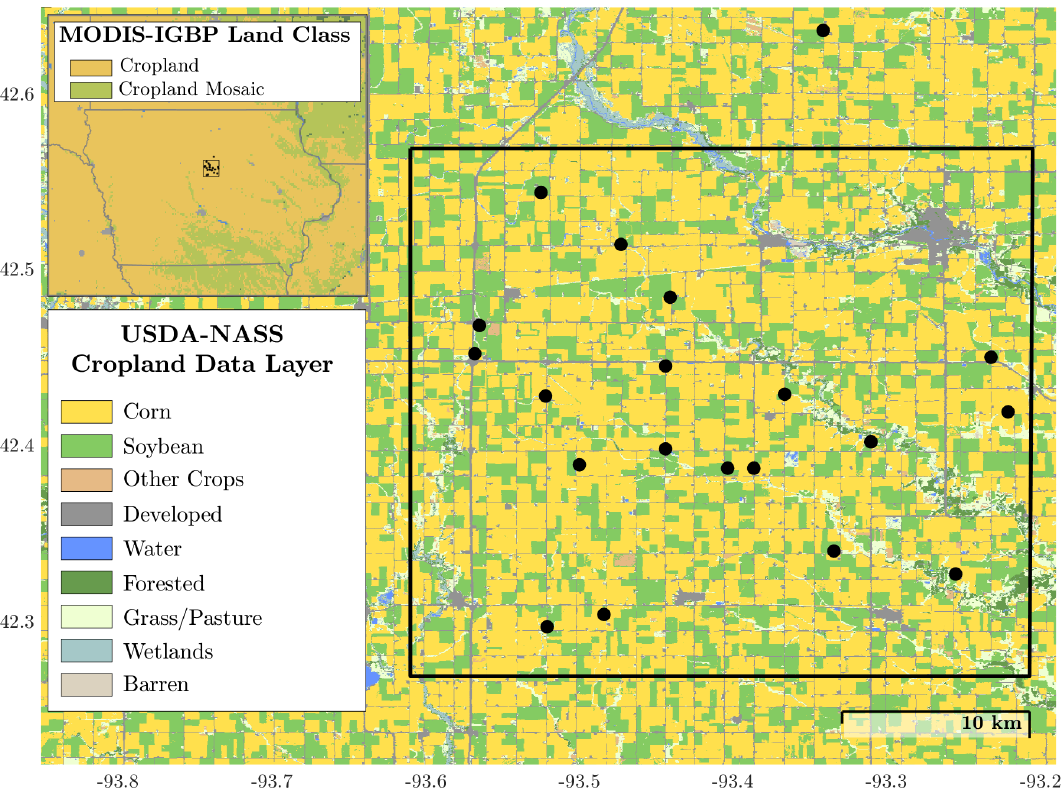
Figure 1. South Fork in situ stations ( • ) and the 33km radiometric resolution ( (cid:3) ) of the nearest SMAP EASE09 cell [row:264,